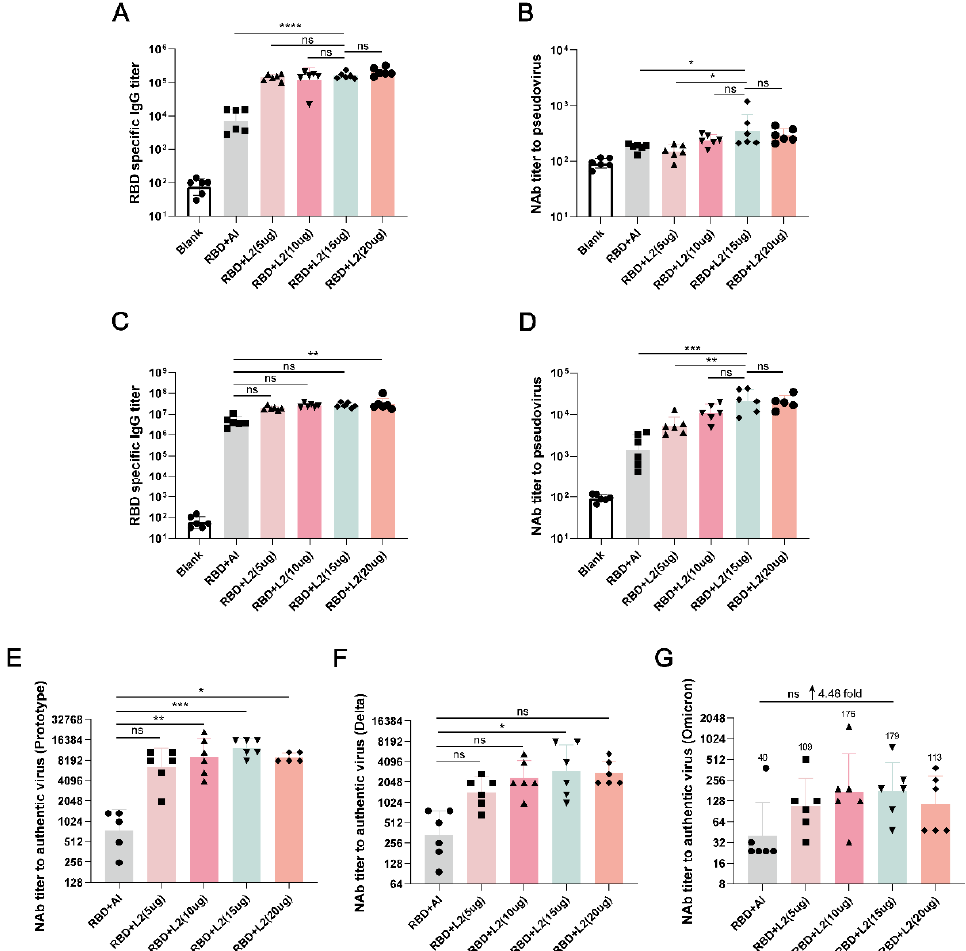
Figure 4. L2 improved the immunogenicity of the RBD compared with aluminum hydroxide (Al) adjuvant. ( A , B ) RBD-specific IgG titers and NAb titers against pseudovirus in Blank, RBD + Al, RBD + L2 (5 µ g), RBD + L2 (10 µ g), RBD + L2 (15 µ g), and RBD + L2 (20 µ g) groups at 14 days after the 1st immunization. ( A ) RBD-specific IgG titers. ( B ) NAb titers against pseudovirus. ( C , D ) RBD- specific IgG titers and NAb titers to pseudovirus in Blank, RBD + Al, RBD + L2 (5 µ g), RBD + L2 (10 µ g), RBD + L2 (15 µ g), and RBD + L2 (20 µ g) groups at 14 days after the 2nd immunization. ( C ) RBD-specific IgG titers. ( D ) NAb titers against pseudovirus. ( E – G ) NAb titers to authentic prototypes, Delta and Omicron, viruses in Blank, RBD + Al, RBD + L2 (5 µ g), RBD + L2 (10 µ g), RBD + L2 (15 µ g), and RBD + L2 (20 µ g) groups at 14 days after the 2nd immunization. ( E ) Prototype virus. ( F ) Delta variant. ( G ) Omicron variant. * p < 0.05. ** p < 0.01. *** p < 0.001. **** p < 0.0001. ↑ , increase. n = 6 for each